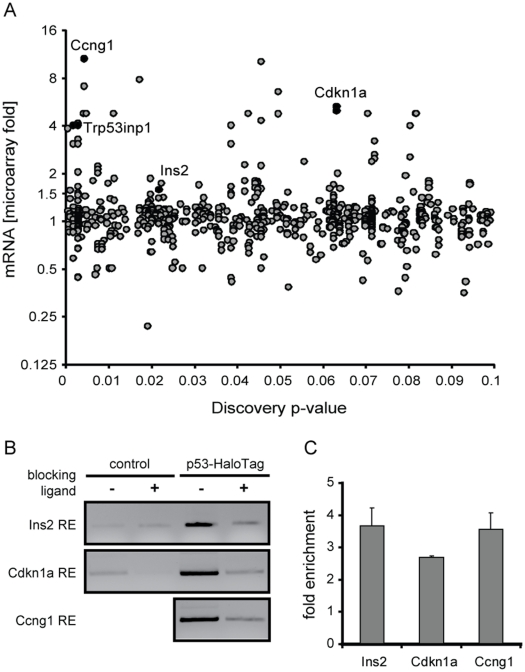
Evaluation of p53 response elements.(A) cisRED prediction of p53 response elements in promoter regions of indicated mouse genes. Discovery p-value is plotted against experimentally determined fold change in gene expression. Selected genes are highlighted. (B) ChIP-PCR analysis of predicted p53-response elements in promoter regions of Ins2, Cdkn1a and Ccng1. Cells were either untransfected (“control”) or transfected with recombinant tagged p53 (“p53-HaloTag”), and p53-bound DNA immunoprecipitated. PCR was then performed on Ins2, Cdkn1a, or Ccng1 regions containing predicted p53-response elements. The presence of blocking ligand helps determine the specificity of the interaction. (C) Fold enrichment of promoter binding is calculated over the corresponding blocking ligand control in the p53-HaloTag condition.